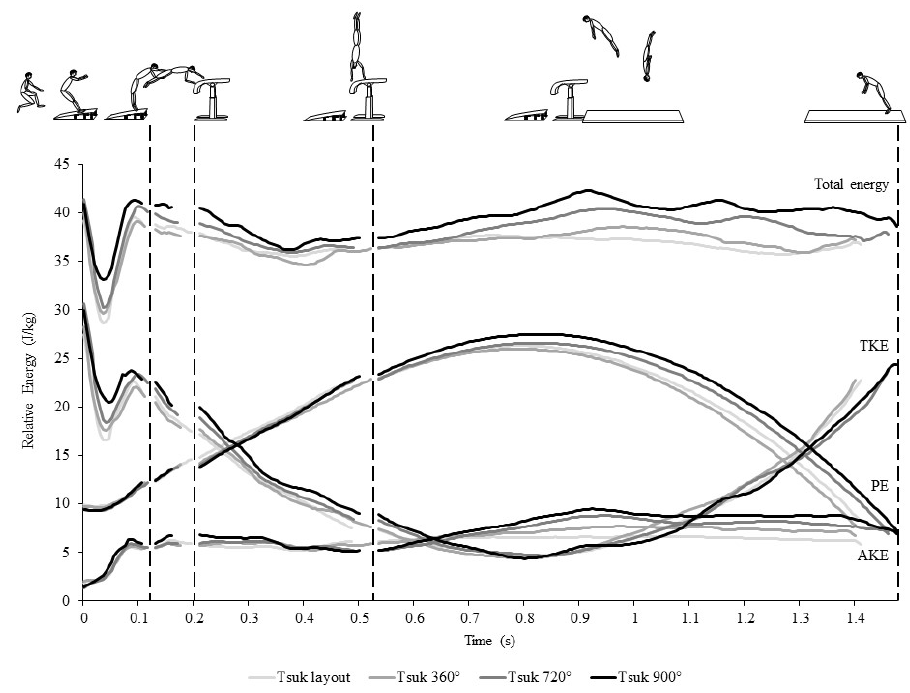
Figure 4. Averaged flux of different energy forms across the different vault phases of simple and difficult Tsukahara vaults (Tsukahara layout without (n = 5) and with 360° (n = 11), 720° (n = 10), and 900° (n = 2) of rotation around longitudinal axis during second flight phase). TKE: translational kinetic energy; PE: potential energy; and AKE: angular kinetic energy.